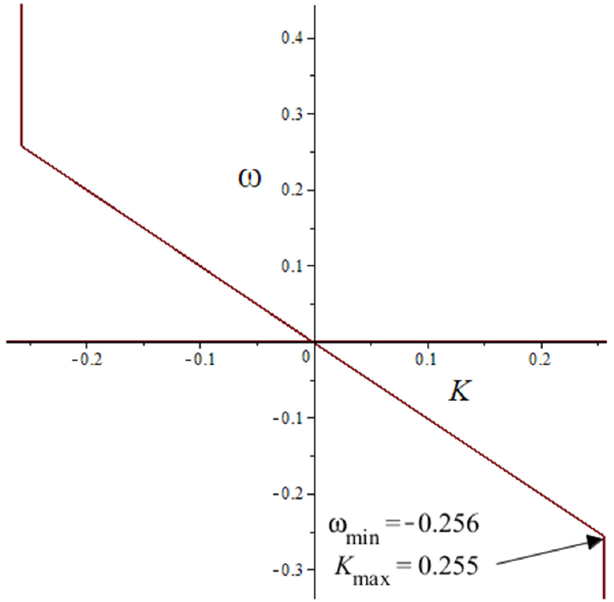
Figure 7. Minimum growth rate as a function of the wave number K for ε 3 = − 7.234118786 × 10 − 36 in a rotational field Ω = 10 with initial hydrostatic stress according to the MGT model.